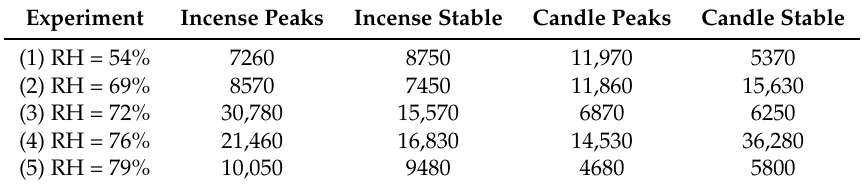
Figure A2. PM 2.5 concentrations and duration of the peaks generated during the different experiments as recorded by the DustTrak. The box and whisker plot horizontal lines represent, from bottom to top, the lower quartile, the median and the upper quartile. The vertical lines are drawn to the smallest and the largest data point that fall within 1.5 times the interquartile range below the lower quartile and above the upper quartile respectively. Each dot is the value recorded for one peak. Table A1. Mean ultrafine particles number concentration (#/cm 3 ) during each experiments measured by the Nanotracer. Relative humidity is given ± two standard